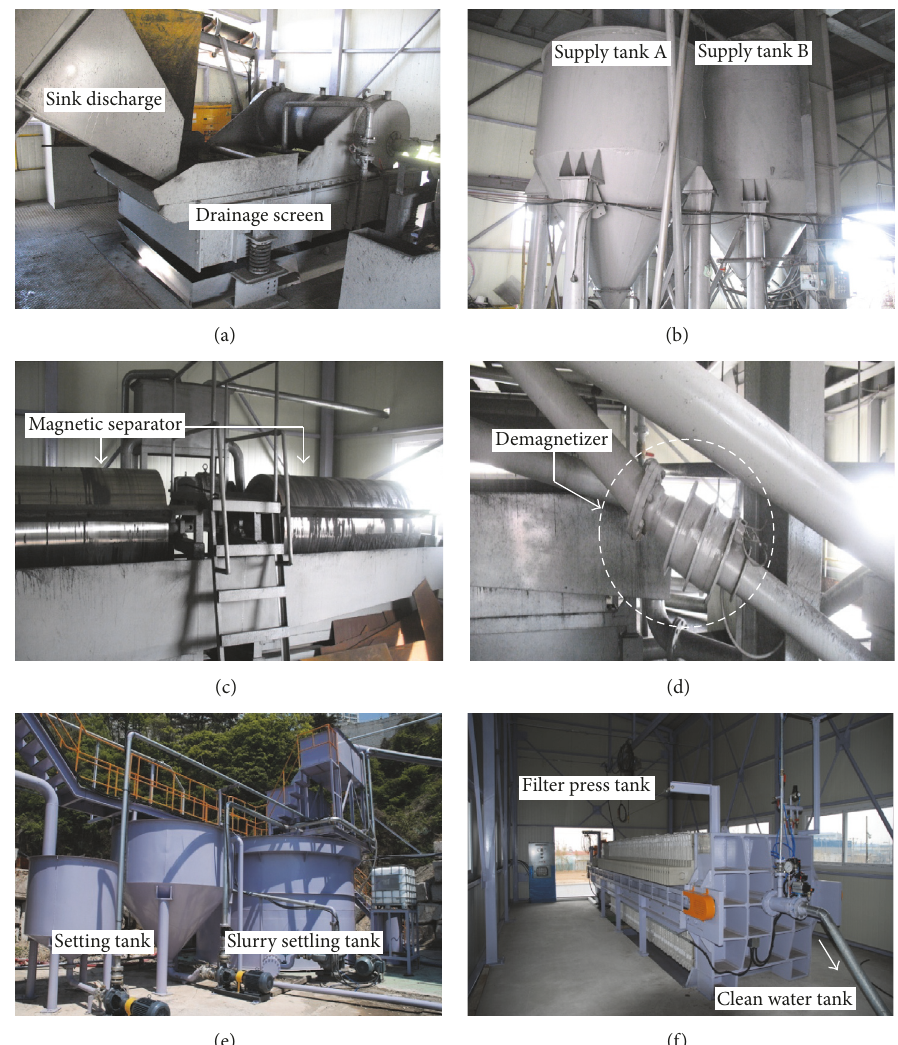
Figure6:PicturesoftheprototypeHMSsysteminthisstudy:(a)entranceofdrainagescreen,(b)supplytanksAandB,(c)magneticseparator, (d) demagnetizer, (e) slurry settling tank, and (f) filter press